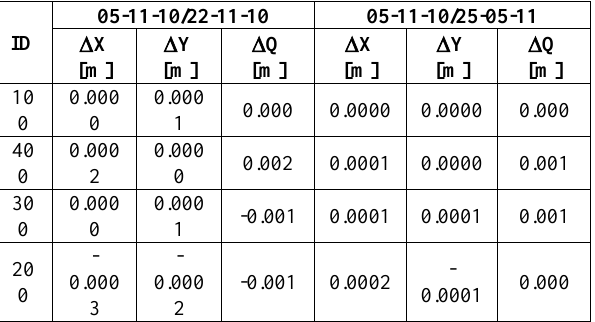
Table 3. Verification the stability of station vertices